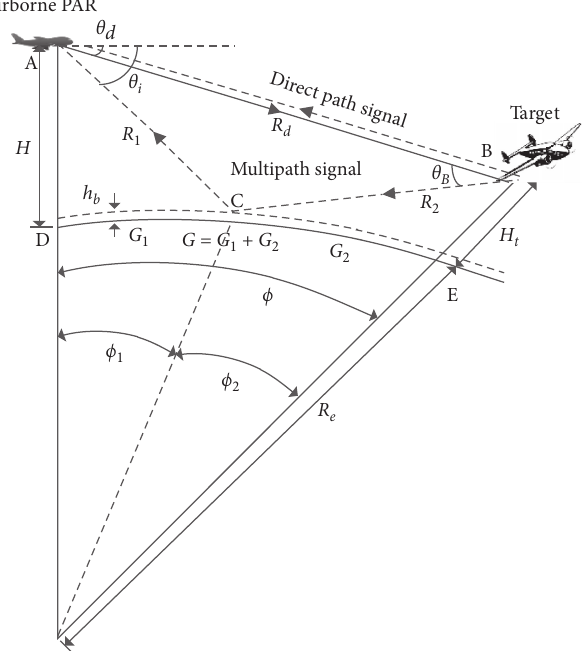
Figure 1: The signal model of airborne PAR in a multipath